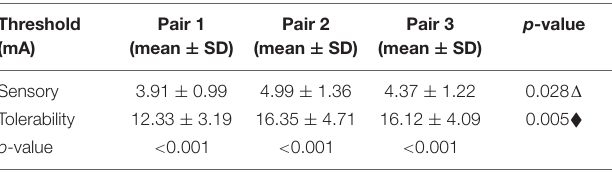
TABLE 3 | The statistical sensory and tolerability threshold results of the transcutaneous electrical nerve stimulation (TENS’s) electrode pairs. Threshold Pair 1 Pair 2 Pair 3 p (mA) (mean ± SD) (mean ± SD) (mean ± SD)